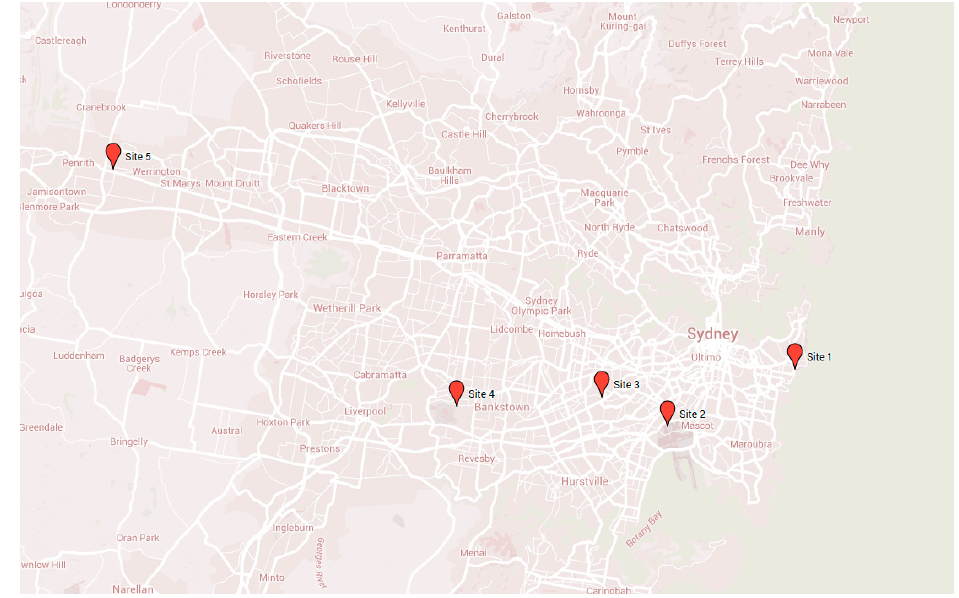
Figure 1. Map of the five Sydney sites.